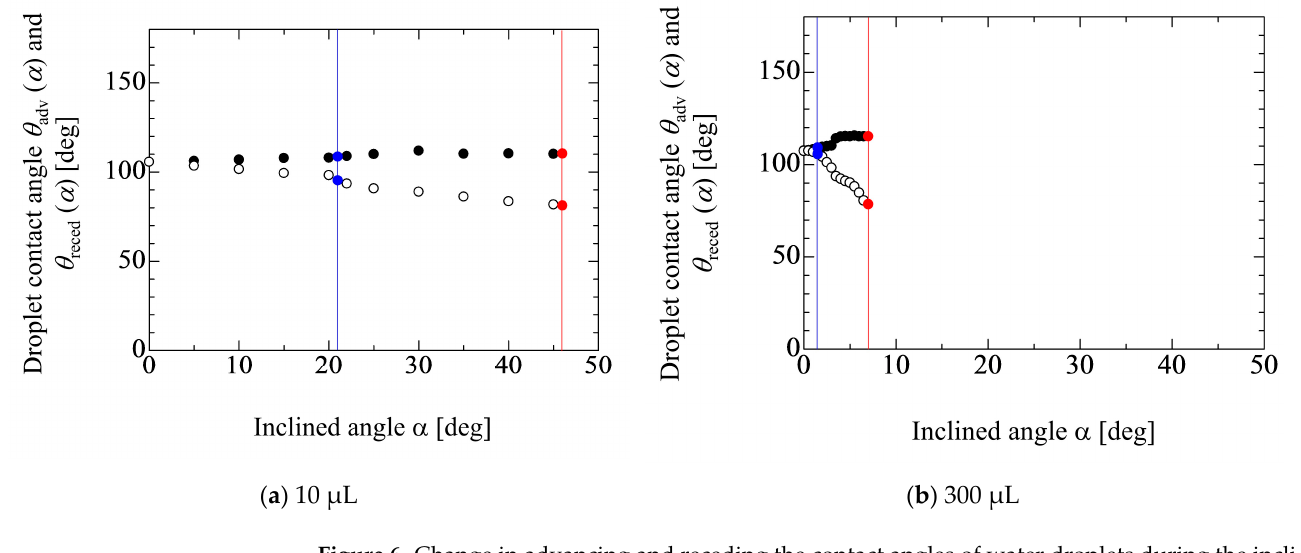
Figure 6. Change in advancing and receding the contact angles of water droplets during the incli- nation of the solid substrate. The blue and red solid lines represent the front and rear contact lines movement, respectively.